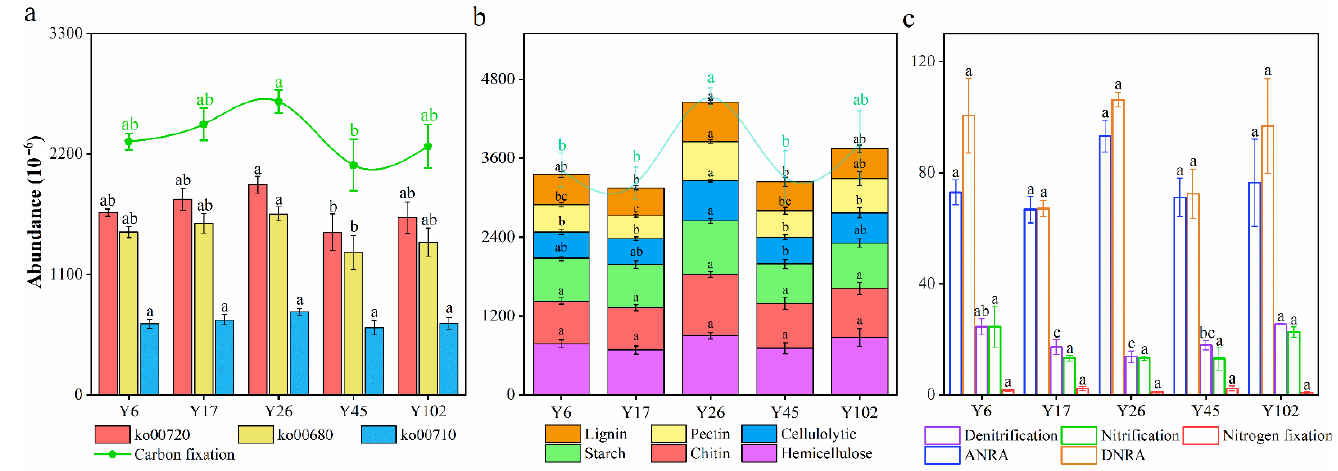
Figure 3. Abundance of the functional pathways involved in potential carbon fixation pathways and methane metabolism pathway ( a ), as well as potential degradation of carbon-containing materials ( b ) and nitrogen cycling processes ( c ).